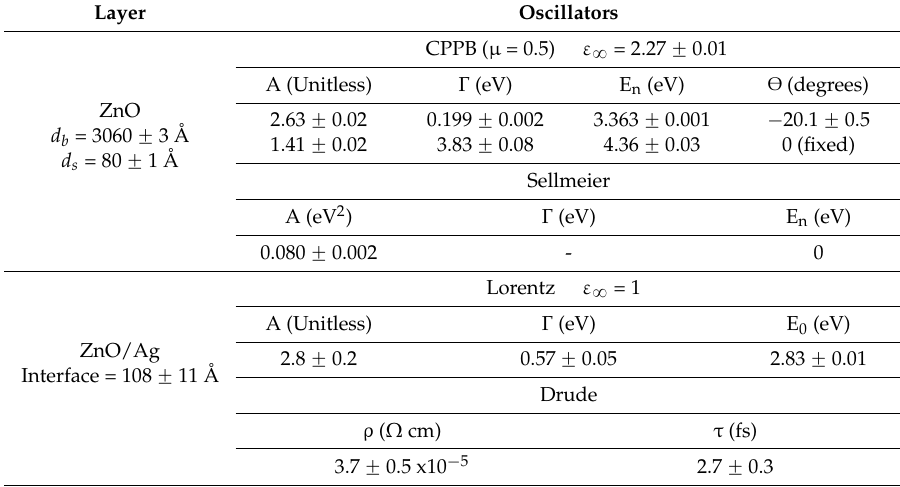
Figure 2. Spectra in ε (arrow pointing left for ε 1 axis, arrow pointing right for ε 2 axis) from 0.734 to 5.0 eV for the 108 ± 1 Å thick ZnO + Ag interface layer parameterized with a Lorentz and a Drude oscillator with parameters listed in Table 3. Table 3. Parameters describing ε and structure for a ZnO film deposited on Ag and the ZnO + Ag interface formed. Experimental ellipsometric spectra were collected in situ after deposition at room temperature in the spectral range from 0.734 to 5.0 eV and fit using least squares regression analysis with an unweighted estimator error function, σ = 7 ˆ 10 ´ 3 . Parameters describing ε for Ag were fixed from Table 2. For ZnO, the parameterization of ε consisted of two CPPB oscillators, a Sellmeier oscillator, and ε 8 . For the ZnO + Ag interface, the parameterization of ε consisted of a Drude oscillator, a Lorentz oscillator, and ε 8 .